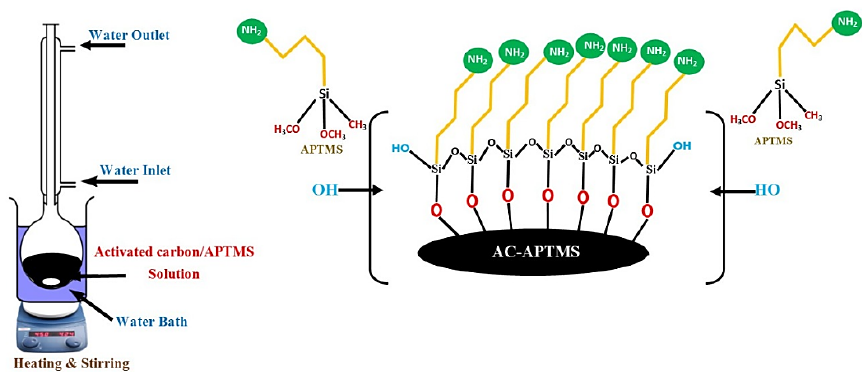
Figure 1. Schematic of amine modified activated carbon by